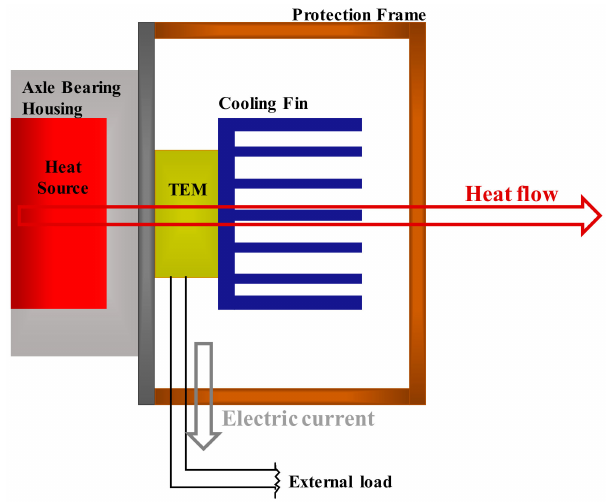
Figure 1. System architecture of thermoelectric energy harvesting